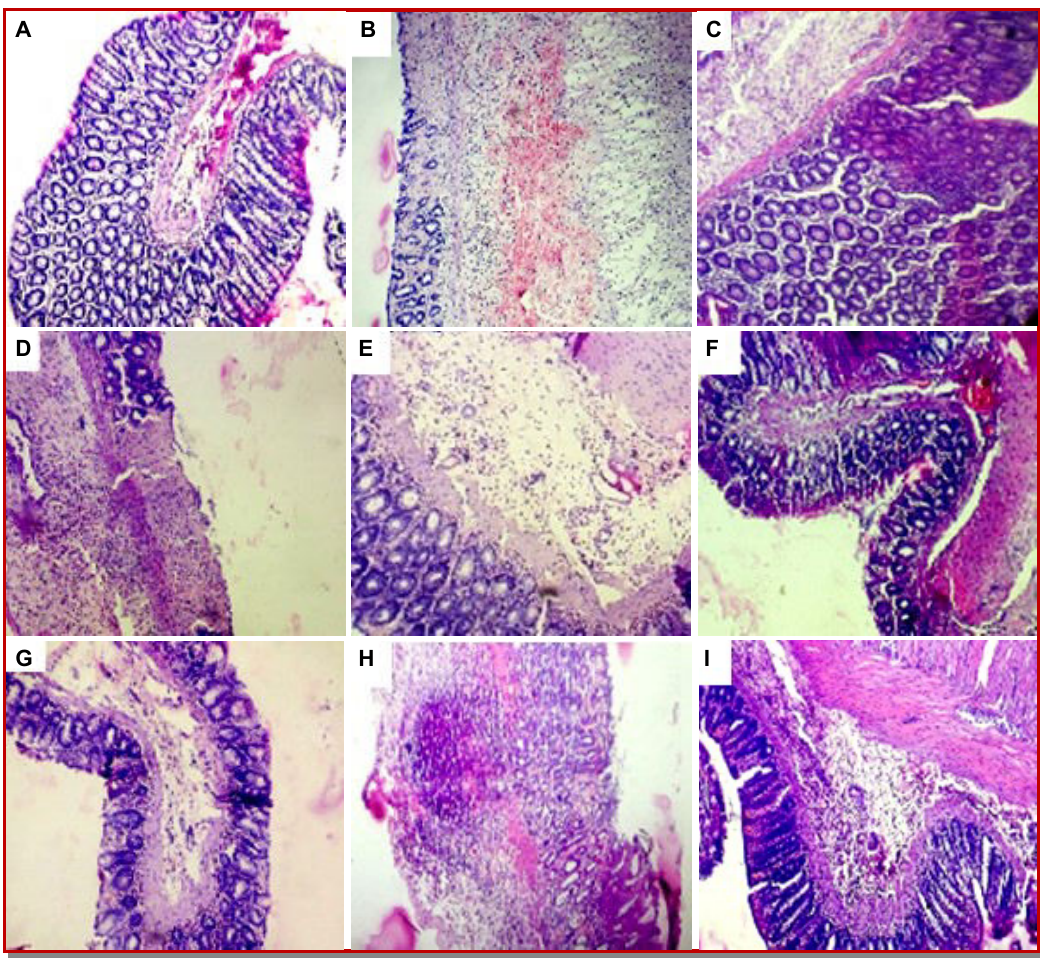
Figure 3: Photomicrographs of sections of colons from rats stained with H and E. Histopathological observations of colon tissue after the treatment with M. pudica leave extract. (A) Normal; (B) Control (4% acetic acid); (C) Pred- nisolone (2 mg/kg); (D) Ethanol extract (200 mg/kg); (E) Ethanol extract (400 mg/kg); (F) Ethyl acetate (200 mg/kg); (G) Ethyl acetate (400 mg/ kg); (H) Chloroform (200 mg/kg); (I) Chloroform (400